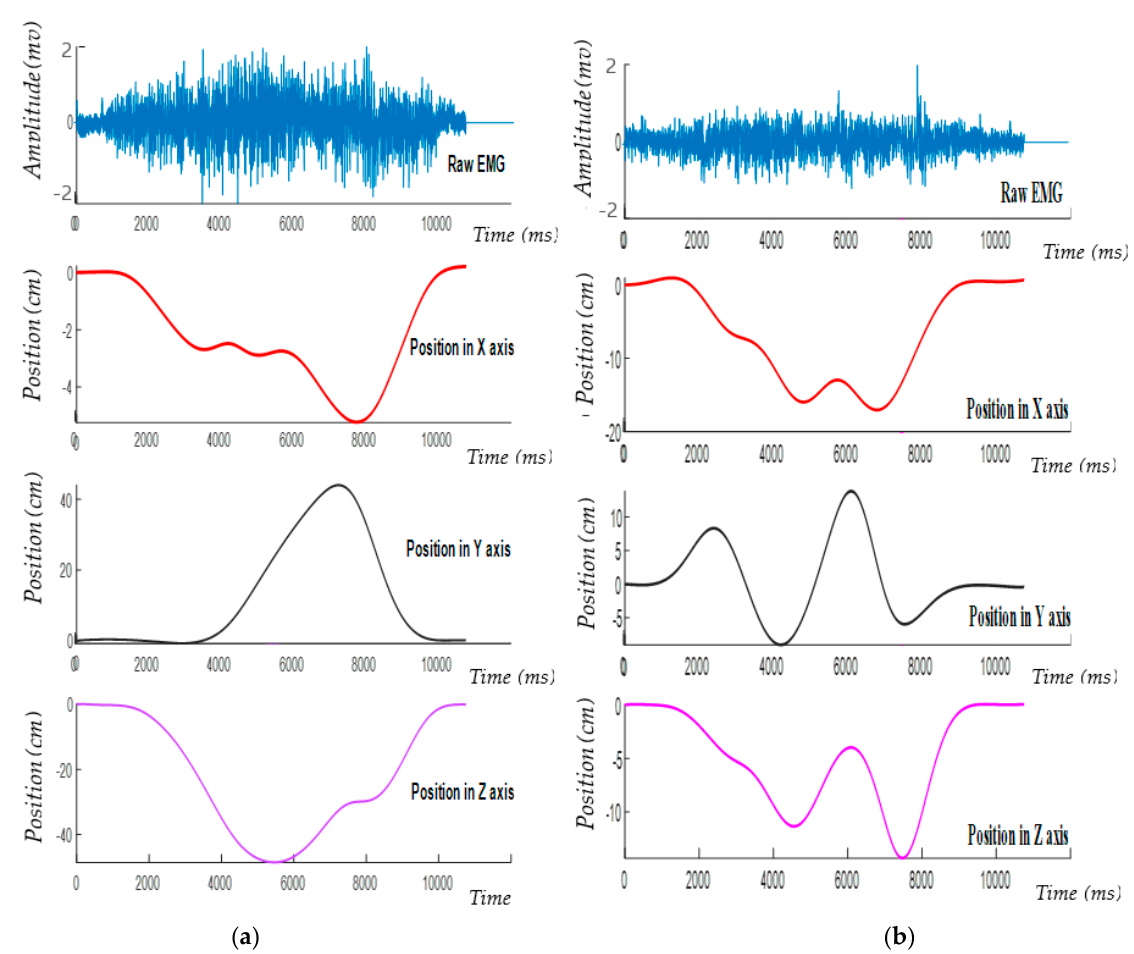
Figure 7. The synchronized EMG and Kinematic signal. ( a ) Task_1; ( b ) Task_2. In both tasks, the top figures represent the amplitude of the raw EMG signal, while the bottom three figures on both the left and right ‐ hand side represent the displacement in the x, y, and z ‐ axis.